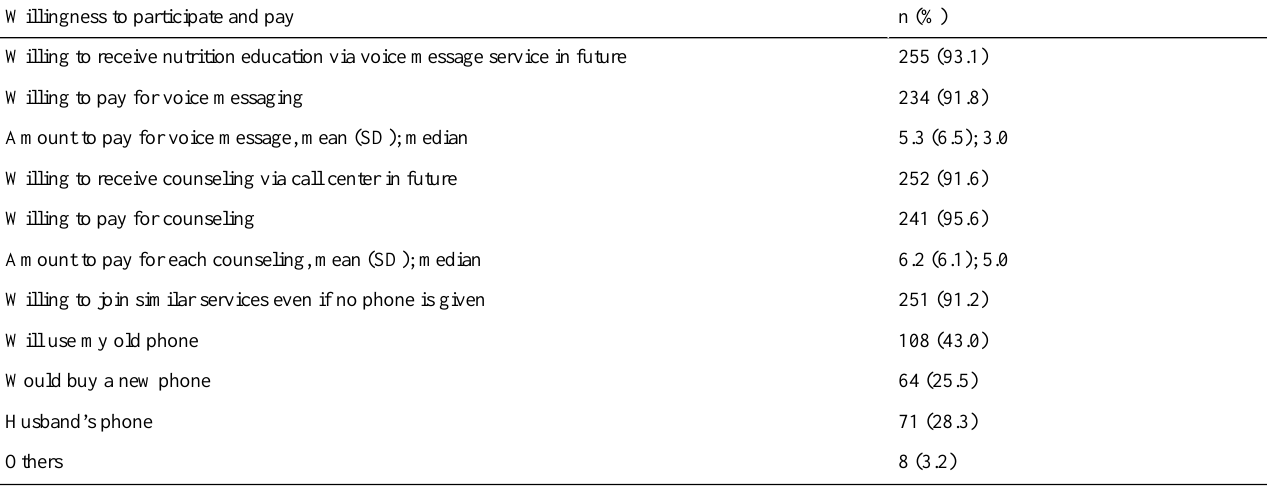
Table 7. Willing to participate and pay for similar services in future from the end of study survey